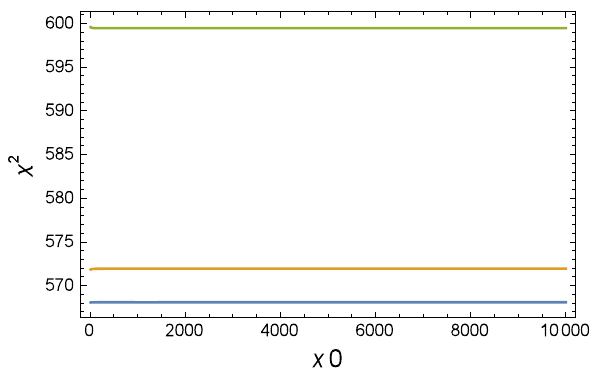
Fig. 4 The blue, orange and green line correspond to the case with (λ,(cid:2) ) = ( 0 . 01 , 0 . 3 ),( 0 . 02 , 0 . 3 ),( 0 . 01 , 0 . 2 ) , respectively. Here x m 0 ranges from 10 to